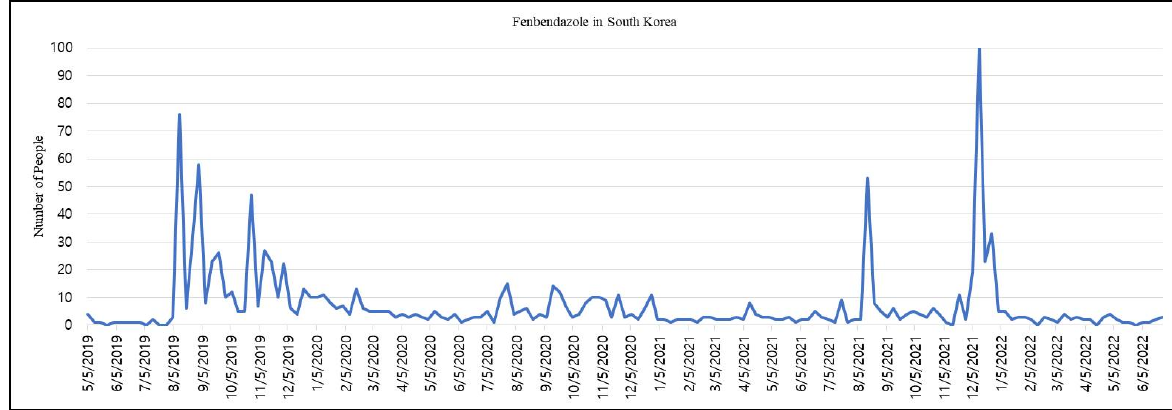
Figure 4. Dissemination of self-administration of fenbendazole. People started following Kim Chul- Min’s story because of celebrity endorsement. The data represent the number of cancer patients or their relatives following Min. A volume of 100 indicates the highest number of searches. The data were collected using Naver Data Lab (a South Korean search engine).